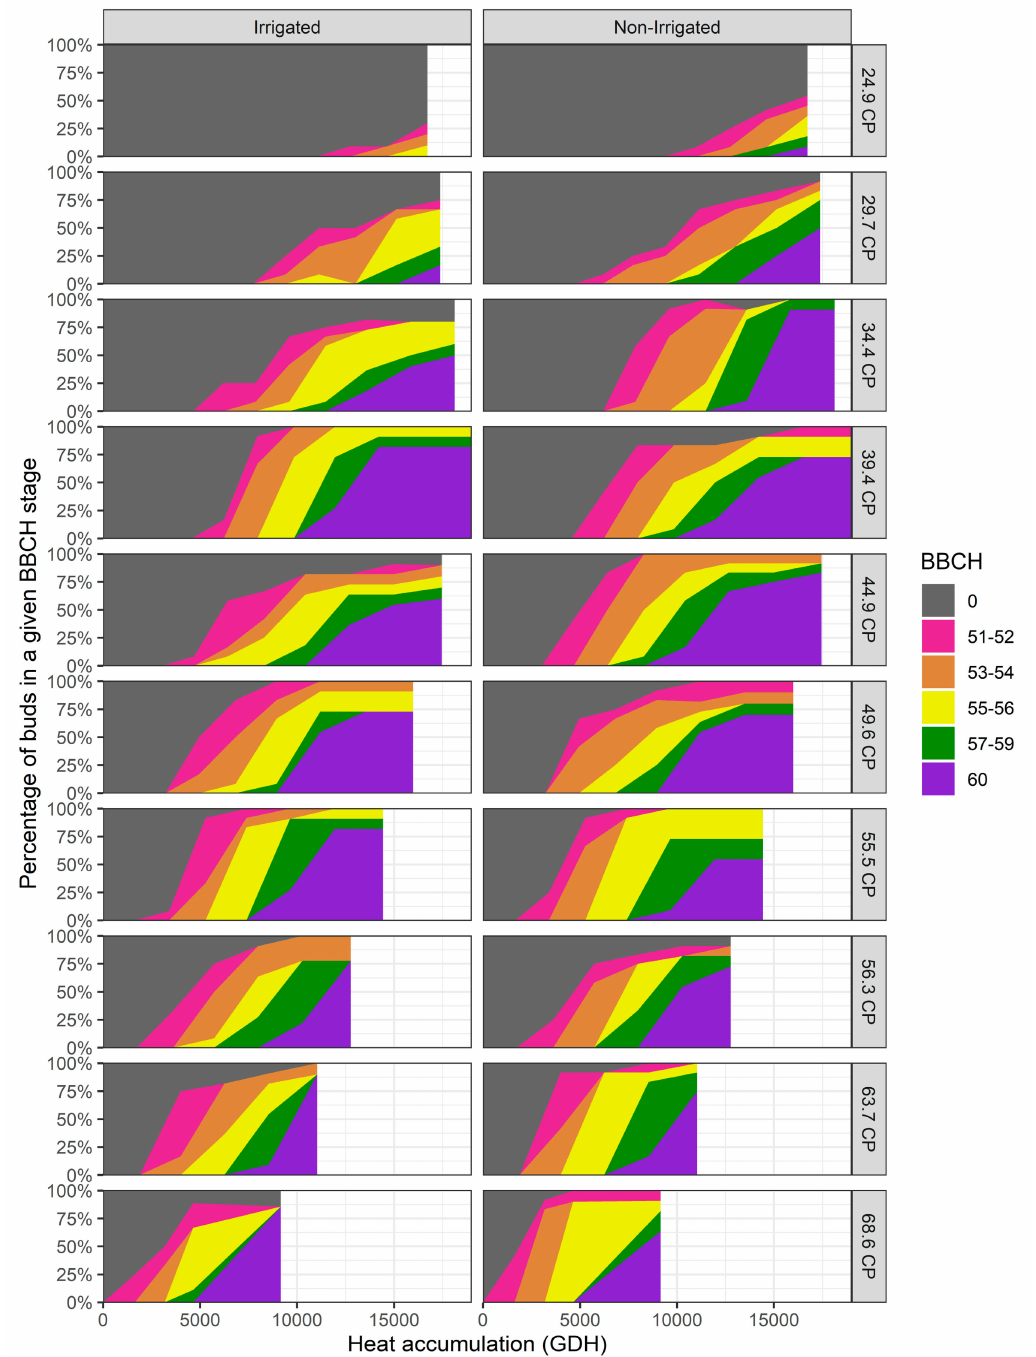
Figure 6. Apical bud development in one-year-old apple shoots (cv. ‘Elstar’) sampled during the winter season of 2018 / 2019 (Table 1). Shoots sampled from trees grown in Campus Klein-Altendorf were exposed to two water regimes (‘irrigated’ and ‘non-irrigated’ panels) during the growing season of 2018. Each row of panels corresponds to a particular sampling date represented by the chill accumulated in the field (in Chill Portions (CP)). The x -axis represents heat accumulation (in Growing Degree Hours (GDHs)) under greenhouse conditions after the shoots had been sampled. The colors represent the sub-stages for the principal growth stages 5 (inflorescence emergence) and 6 (flowering) of reproductive buds, according to the BBCH scale. We monitored a total of 213 apical reproductive buds (27 apical vegetative buds were